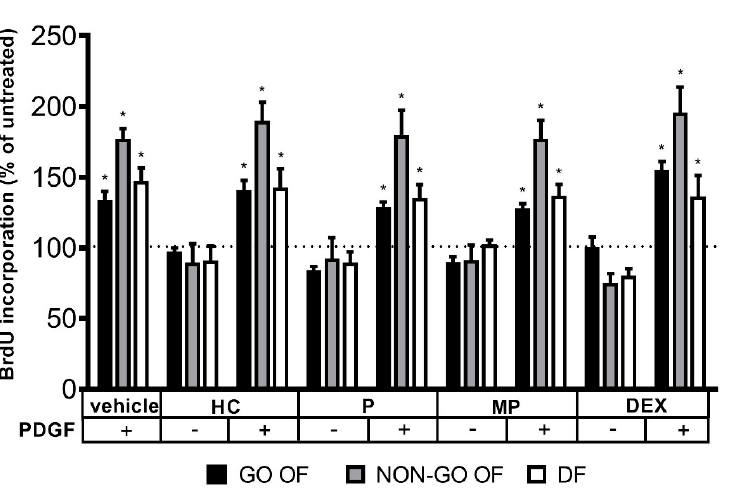
Figure 5. The proliferation rate of PDGF-BB treated cells. The dotted line represents the basal proliferation rate. Data were analyzed using repeated measure ANOVA followed by Dunnett’s test. Result shown are the mean ± SEM. * p < 0.0001. GO OF—Graves’ orbitopathy fibroblasts, NON-GO OF—control orbital fibroblasts, DF—dermal fibroblasts, BrdU—5-bromo-2’-deoxyuridine, PDGF—platelet derived growth factor BB, HC—hydrocortisone, P—prednisolone, MP— methylprednisolone, DEX—dexamethasone .